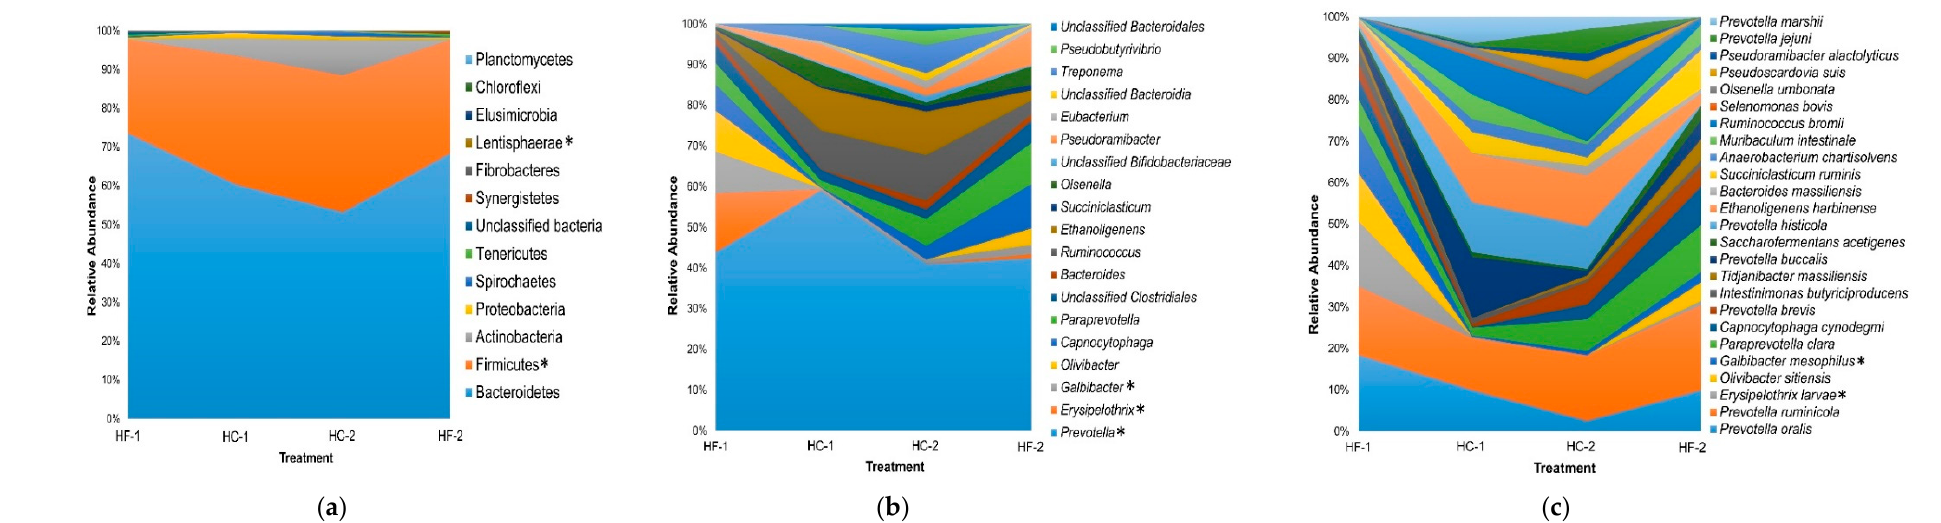
Figure 2. Relative abundance of the observed ( a ) phyla, ( b ) genera, and ( c ) species from the four different treatments. Relative abundance was computed using Quantitative Insights Into Microbial Ecology (QIIME) [39]. HF-1, high-forage diet; HC-1, high-concentrate diet; HC-2, high-concentrate diet; HF-2, high-forage diet. Asterisk (*) denotes significant differences ( p < 0.05).